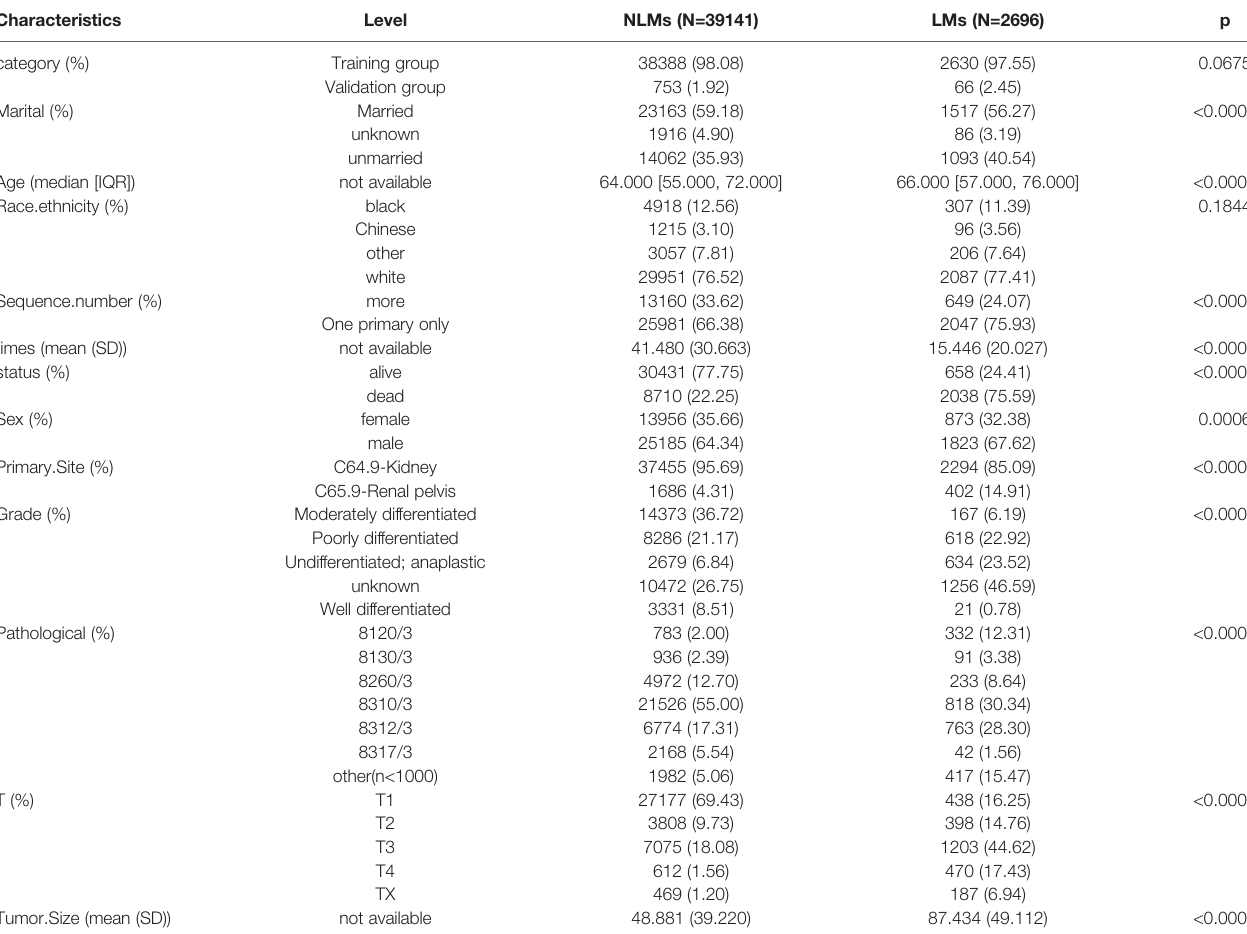
TABLE 2 | Baseline renal cancer patients with and without lymph node metastasis.